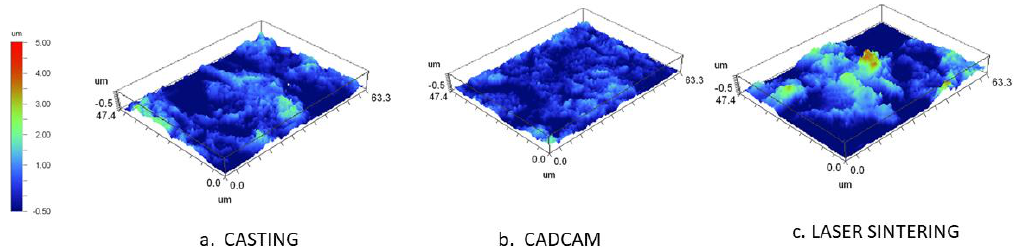
Figure 6. Results of roughness (Sa) and the surface area index for the different dental restorations.